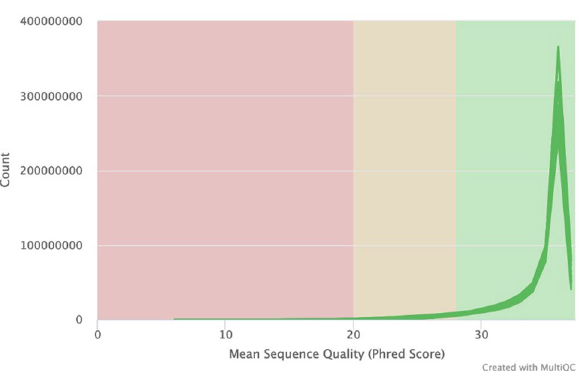
Figure 2. FastQC per sequence quality scores for all seven samples sequenced. All samples had universally high-quality scores.